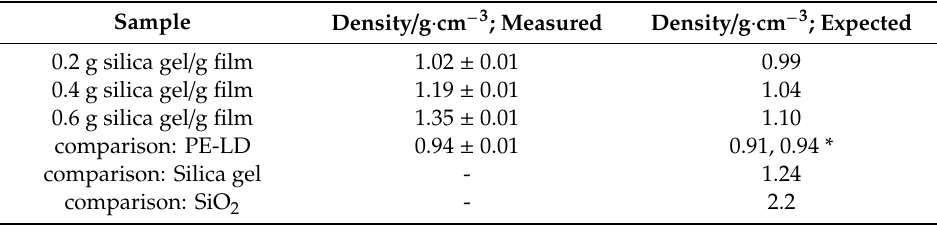
Table 2. Measured and expected densities of films; * from [81].